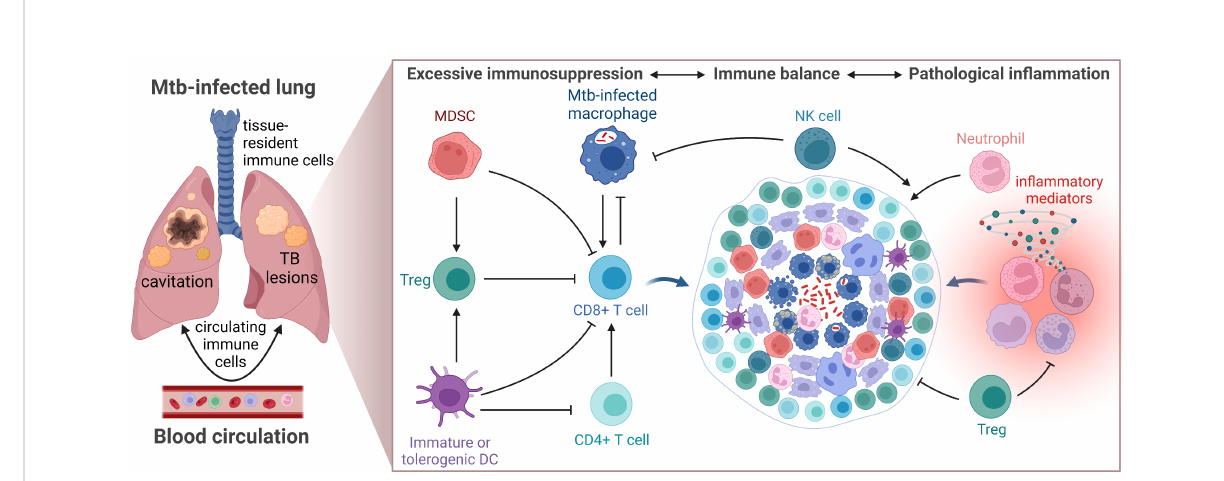
FIGURE 3 Schematic illustration of the TB granuloma microenvironment. Activation (arrows) and inhibition (closed lines) of immune cells must be strictly controlled to maintain immune balance and prevent TB disease